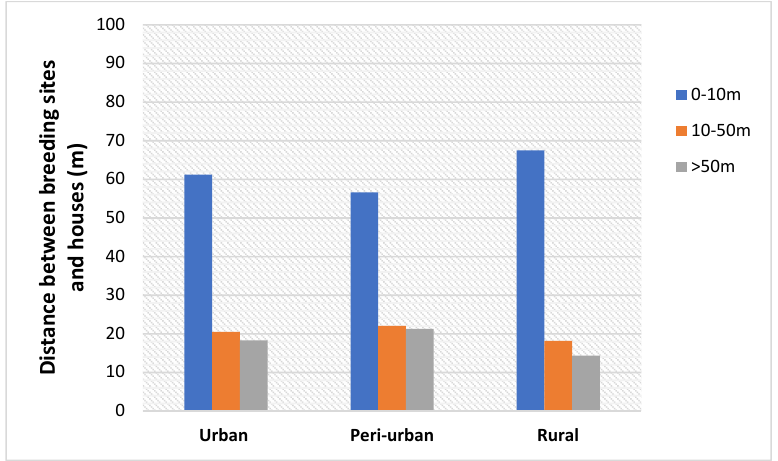
Figure 4. Distance between breeding habitats and houses.